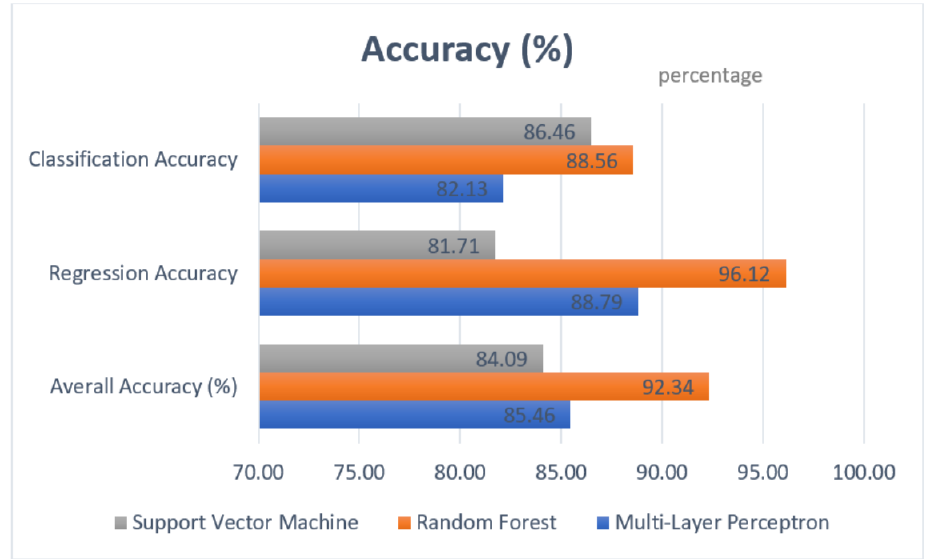
Figure 9. Algorithm accuracy